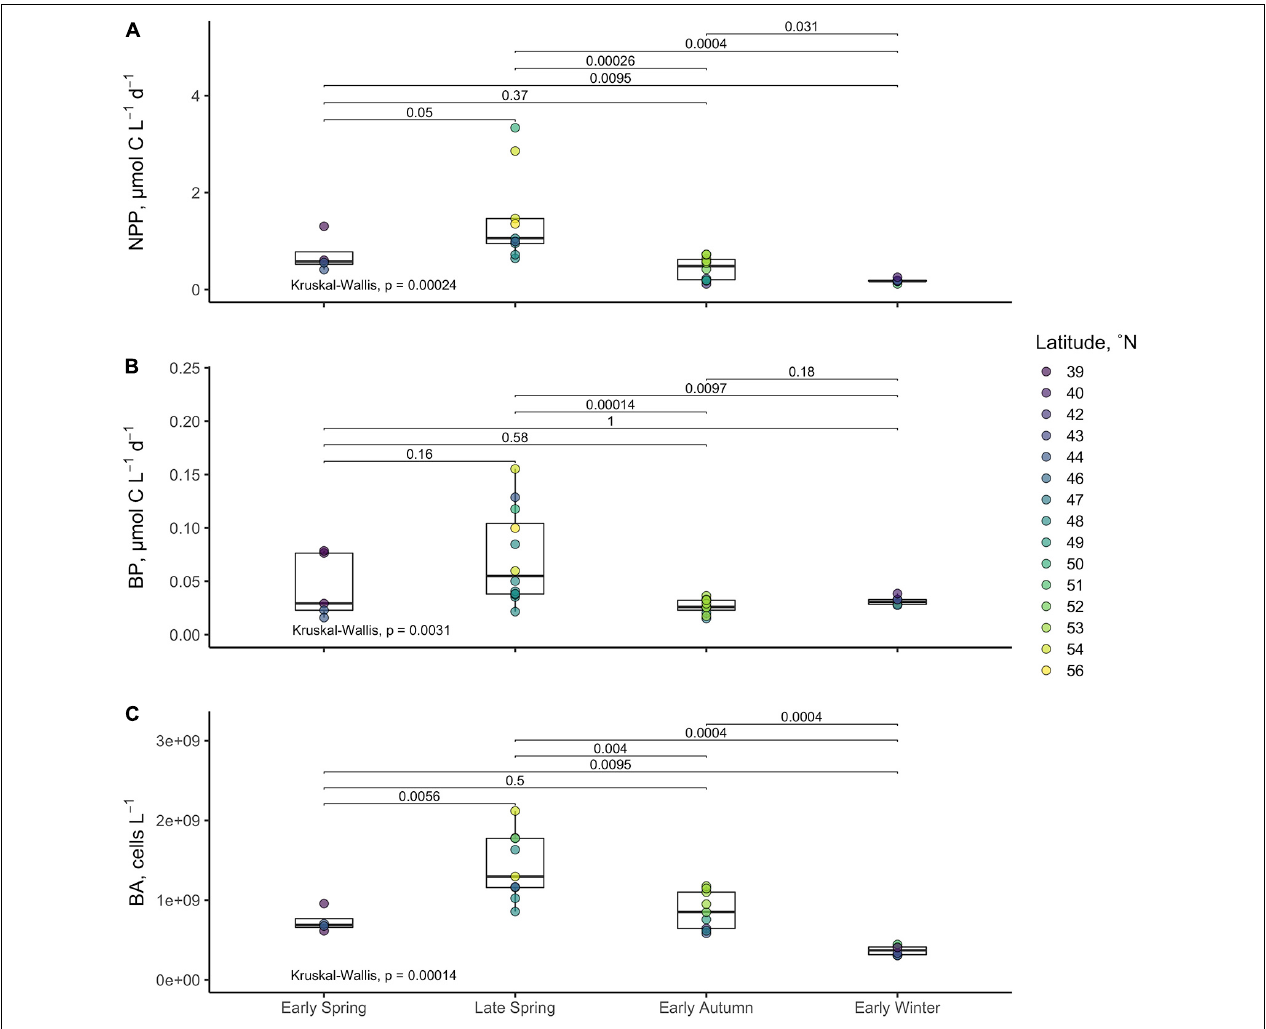
FIGURE 6 | Averages of net primary production [NPP (A) ], bacterioplankton production [BP (B) ], and bacterioplankton abundance (C) within the euphotic zone for each station. Boxes represent the 1.5 interquartile range, with the internal solid line representing the median. Circles represent data points. p -values are reported for the nonparametric Kruskal–Wallis test (one-way ANOVA on ranks), which tests if the means of all groups are equal. Level of significance is also reported for the nonparametric two-sample Wilcoxon test, which tests whether the means between two groups are equal.